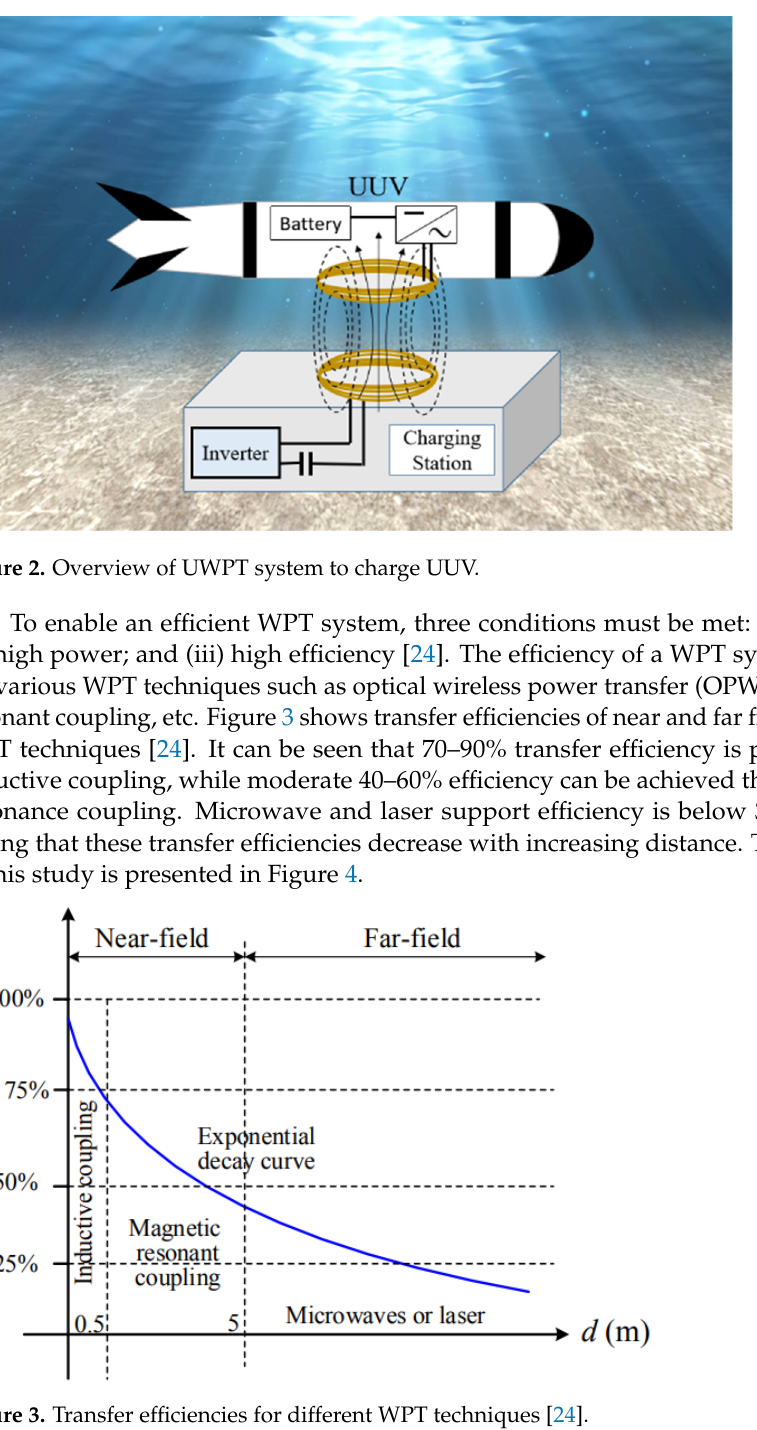
Figure 3. Transfer efficiencies for different WPT techniques [24].